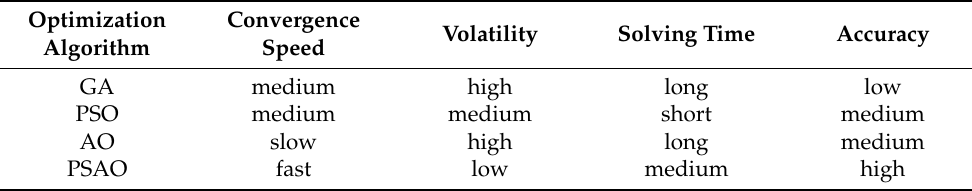
Table 6. Comparison table of algorithms’ characteristics.